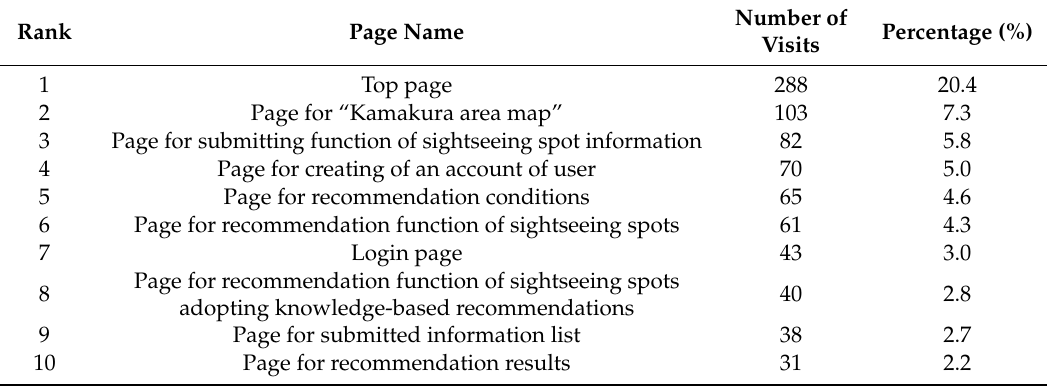
Table 2. Number of visits for each page (top